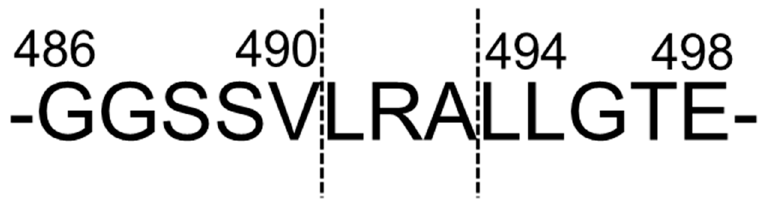
Figure 3. Major NO-mediated vasodilation pathways. Endogenous peptide hormones activate NO production by the phosphorylation of PI3K, Akt and eNOS. sGC, soluble guanylate cyclases; NO, nitric oxide; eNOS, endothelial nitric oxide synthase; Akt, protein kinase b; BR2, Bradykinin receptor